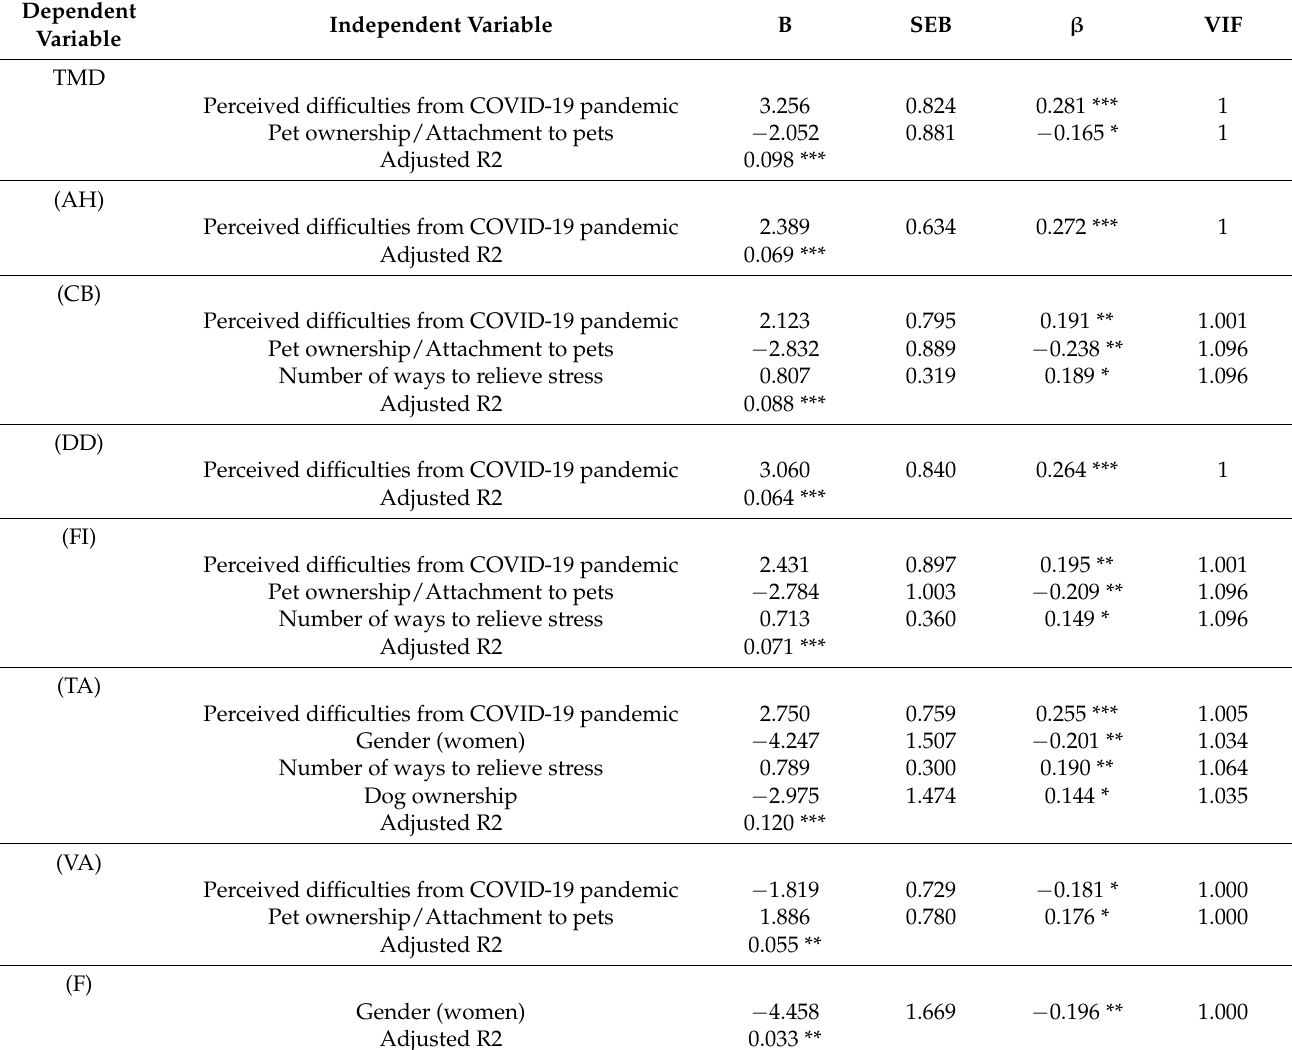
Table 2. Summary of Multiple Regression Analyses for TMD and Seven Subscales of